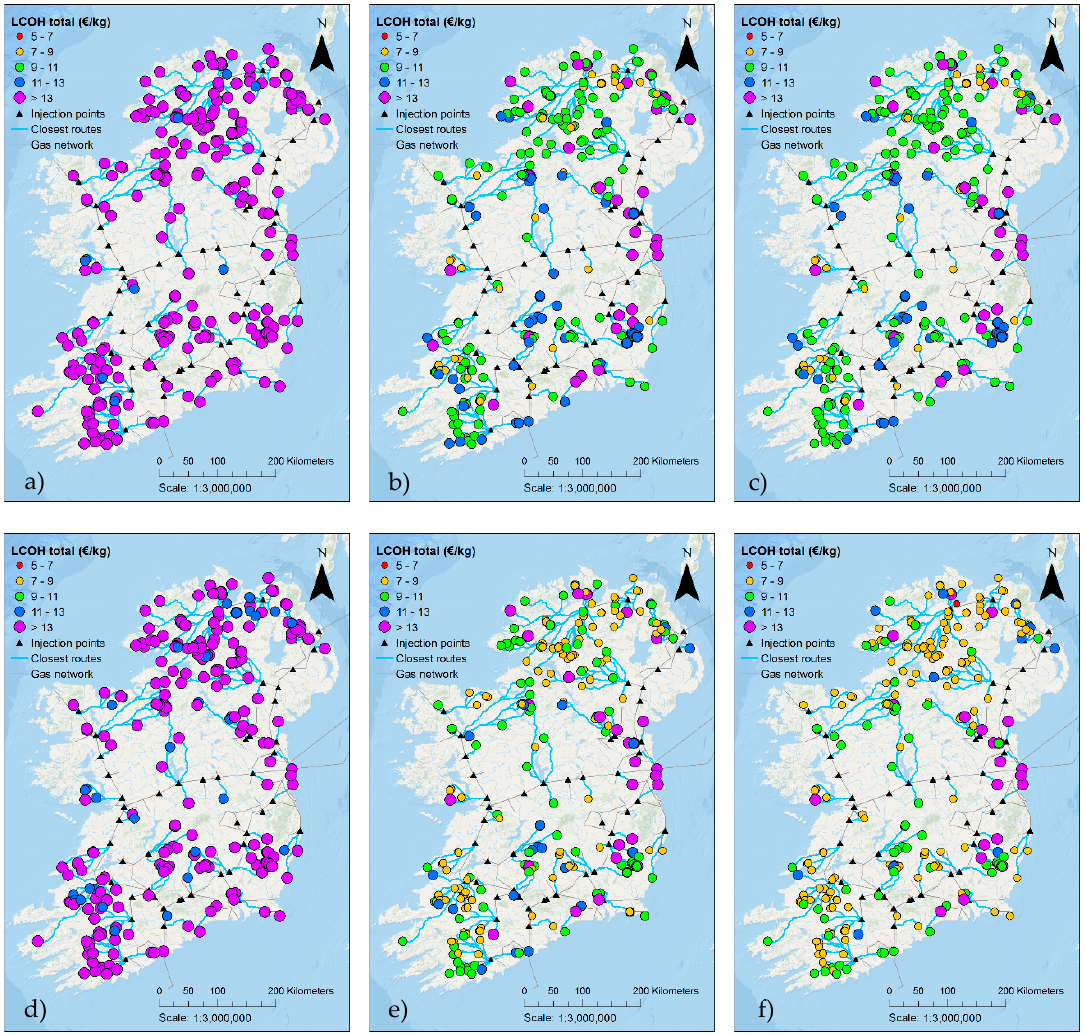
Figure 10. Current LCOH total of ( a ) curtailed wind operation at high electricity prices, ( b ) available wind operation at high electricity prices, and ( c ) full capacity operation at high electricity prices, ( d ) curtailed wind operation at low electricity prices, ( e ) available wind operation at low electricity prices, and ( f ) full capacity operation at low electricity prices, calculated by the WHS model for all wind farms in Ireland.